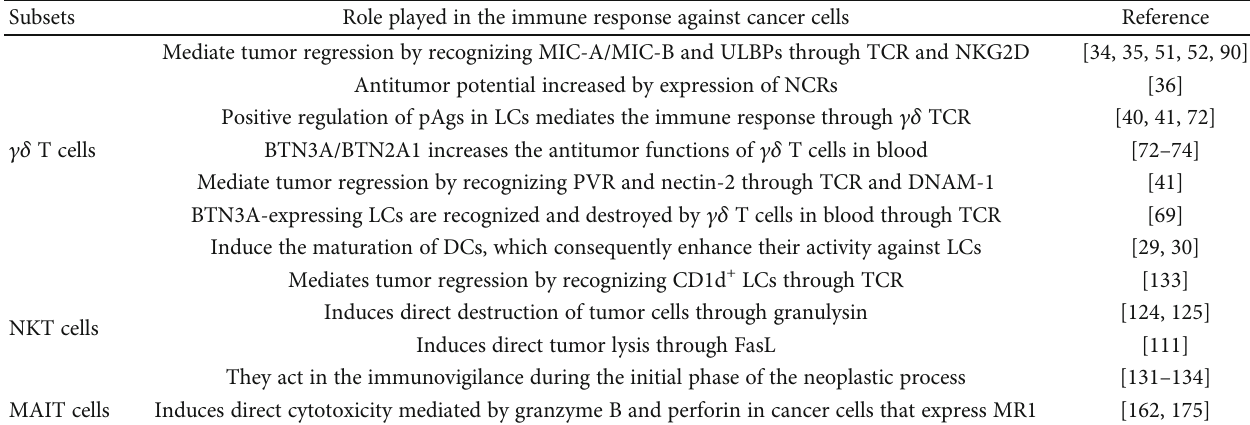
MAIT cells Induces direct cytotoxicity mediated by granzyme B and perforin in cancer cells that express